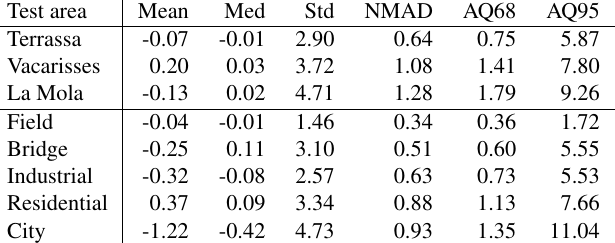
Table 4: Statistical evaluation of the euclidean distance between LIDAR reference points and Worldview-1 DSMs.